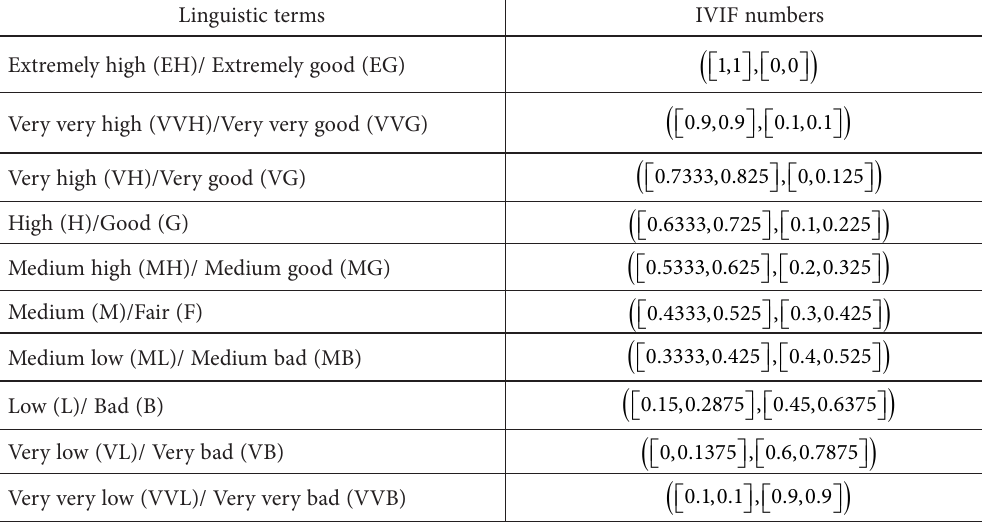
Table 1. Linguistic variables and corresponding IVIF numbers